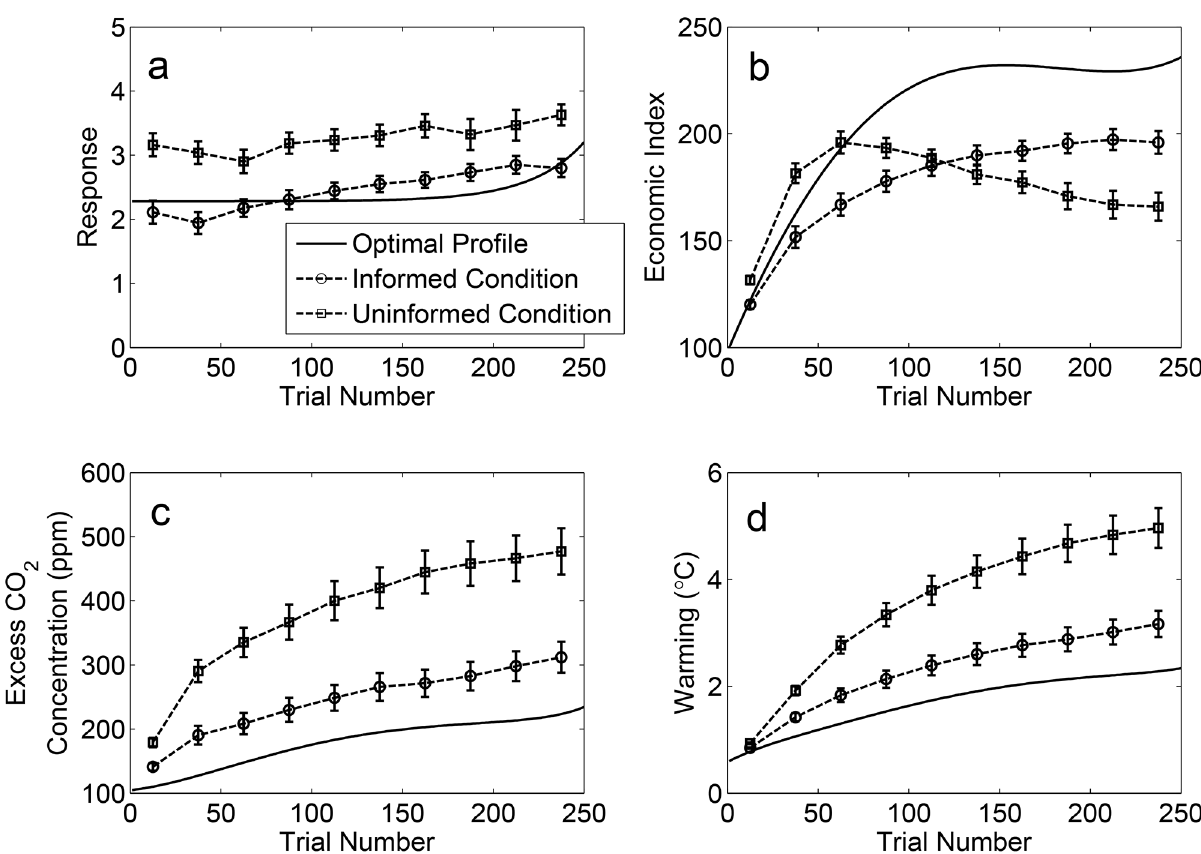
Fig 5. System dynamics associated with the optimal response profile (solid curves)overlaid with data from informed and uninformed conditions (dashed lines). Data are collapsedacross cover story conditions and across Experiments 1 and 2. The panels show trajectories for responses (a), economicindex (b), excess CO 2 concentration (c), and warming(d). Error bars are one standarderror of the